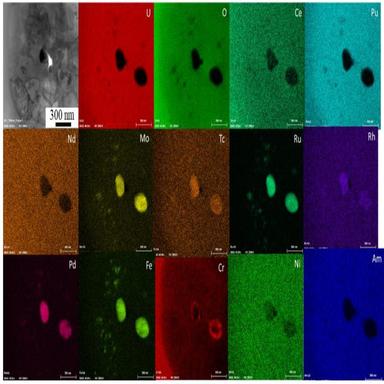
The EDS maps form TEM foil A in 8. These are intensity maps in the fuel near the FCCI/Fuel boundary. EDS of two large precipitates and several smaller precipitates in the fuel. There is some heterogeneity in the elements of the 5 metal precipitates. Also, the enrichment of Cr and O in the FCCI layer can be observed.